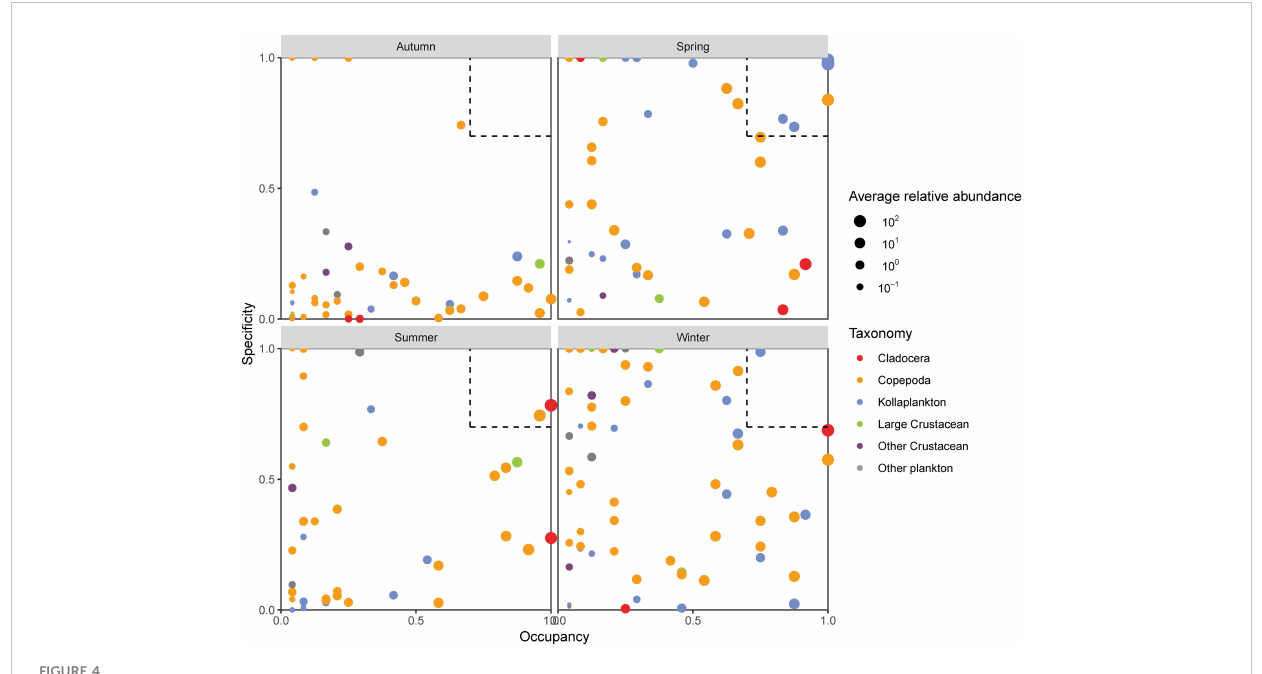
FIGURE 4 SPEC-OCCU plots of